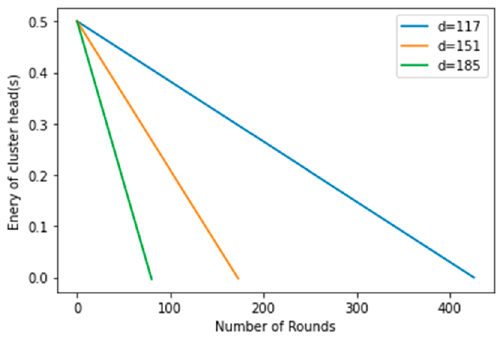
Figure 16. Effect of distance of cluster heads (CHs) from BS on the network lifespan.